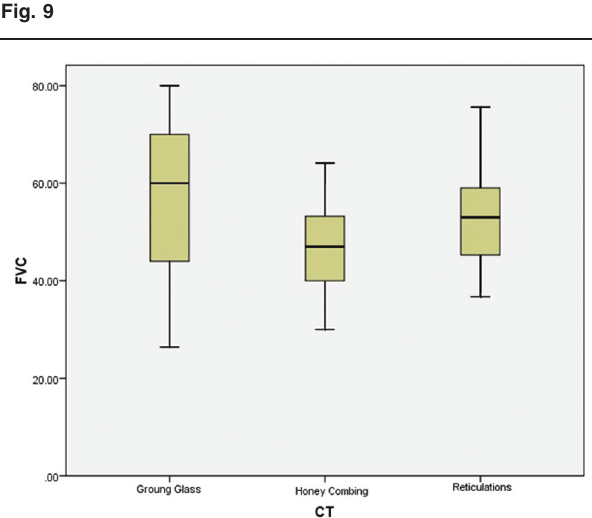
Association between computed tomography findings and forced vital capacity in the three